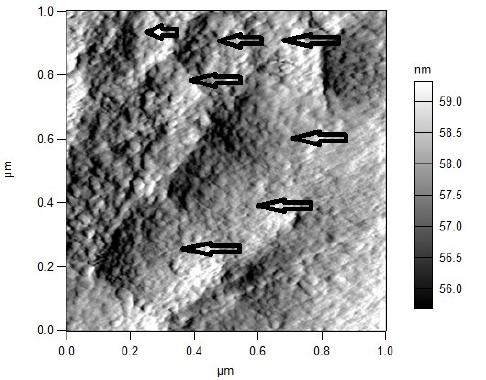
Figure 7. Viruses expressed in the intercellular space at 24 h p.i